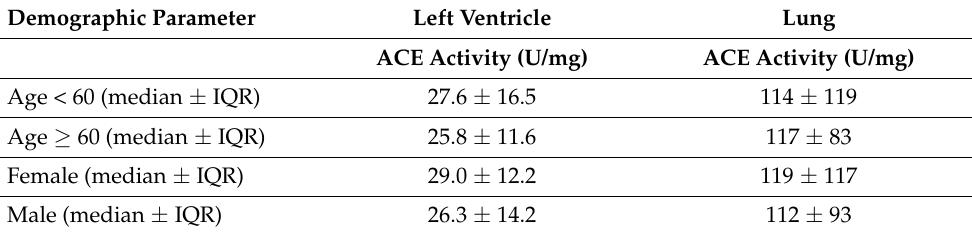
Table 2. There are no effects of age and gender on ACE activities in sera and